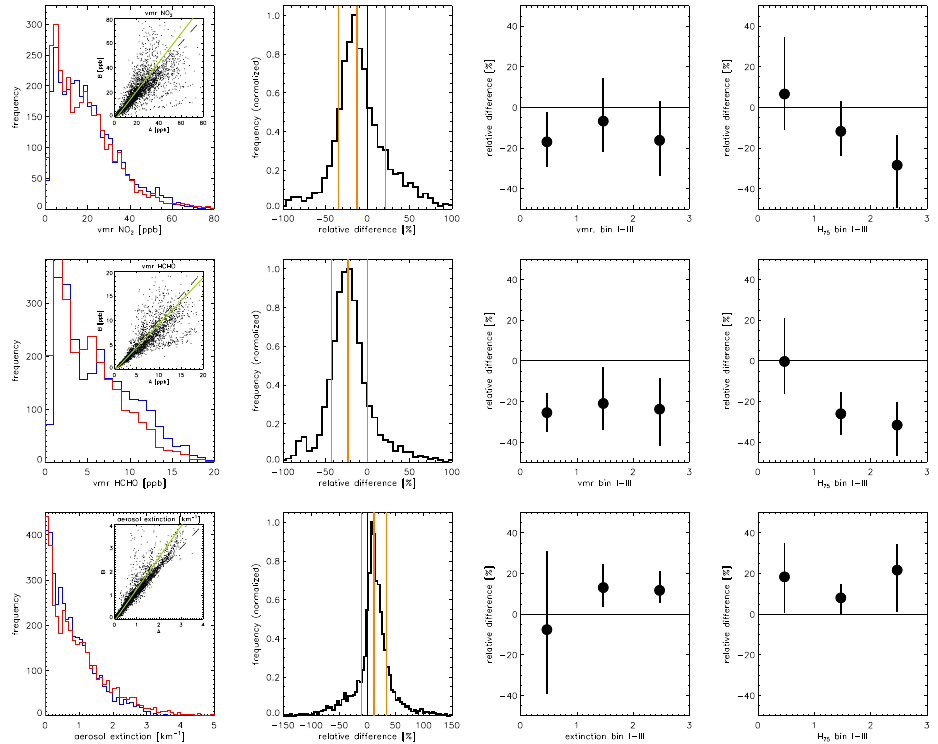
Figure 21. Statistics of near-surface concentration retrievals. The three rows refer to volume mixing ratios of NO 2 (row 1) and HCHO (row 2) and aerosol extinction (row 3). Left column: frequency distributions obtained with method A (blue) and B (red). Second column: frequency distribution of relative differences (B minus A). Lines in orange indicate the quartiles. Column 3: relative differences sorted as a function of the volume mixing ratio (rows 1 and 2) and aerosol extinction (row 3). Column 4: relative difference sorted as a function of H 75 where the three bins refer to the lowest 25%, middle 50% and highest 25%